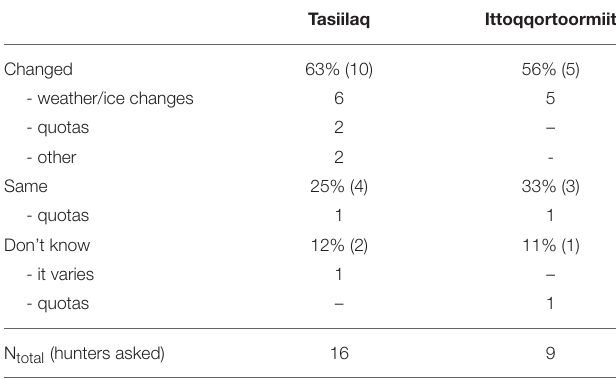
TABLE 2 | Types of responses to question 25: “Has the best time to hunt polar bears changed during the last 10–15 years?”, and reasons given for question 25a: “why?”